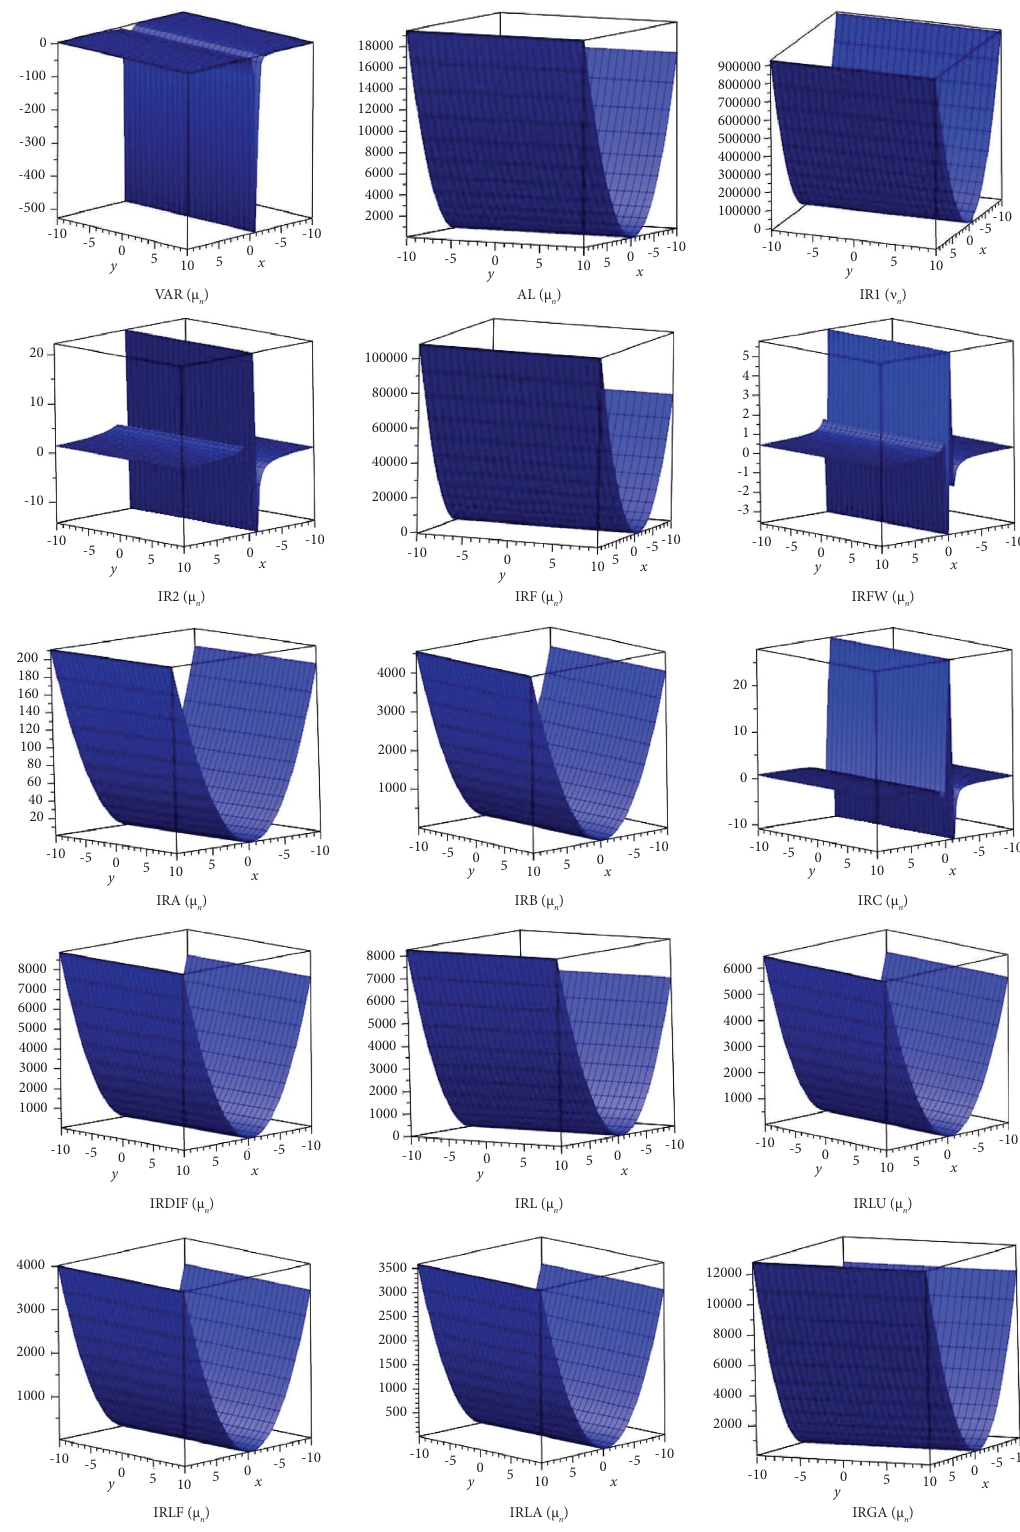
Figure 7: 3D plot for irregularity indices for μ